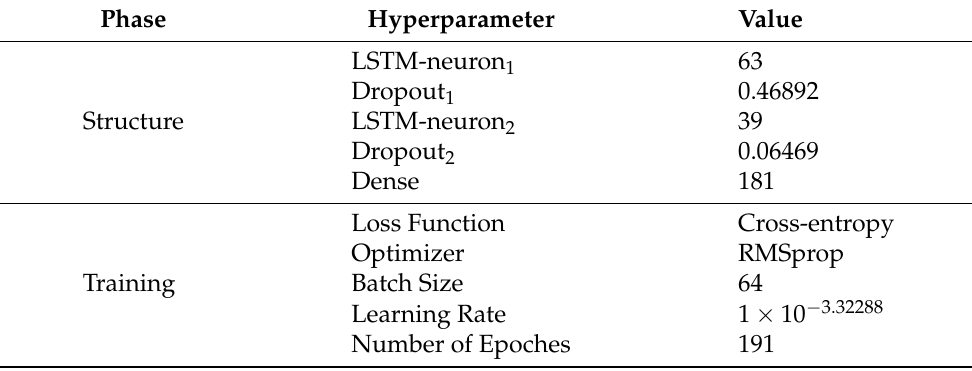
Table 4. The summarized hyperparameters of 2-Stacked LSTM network found by SigOpt.